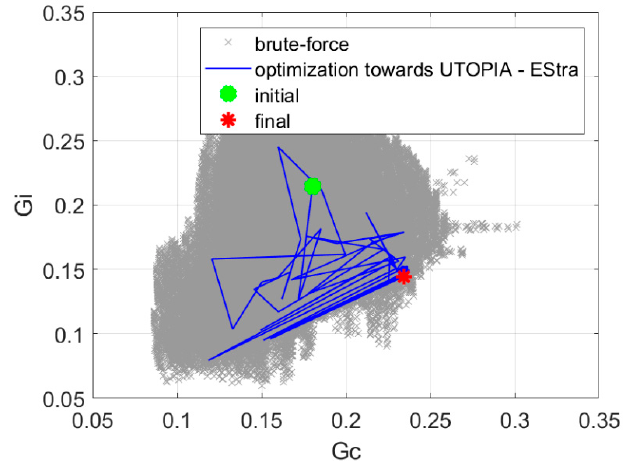
Figure 11. The history of optimization in the space of objective function components for optimization with nadir point distance maximization.